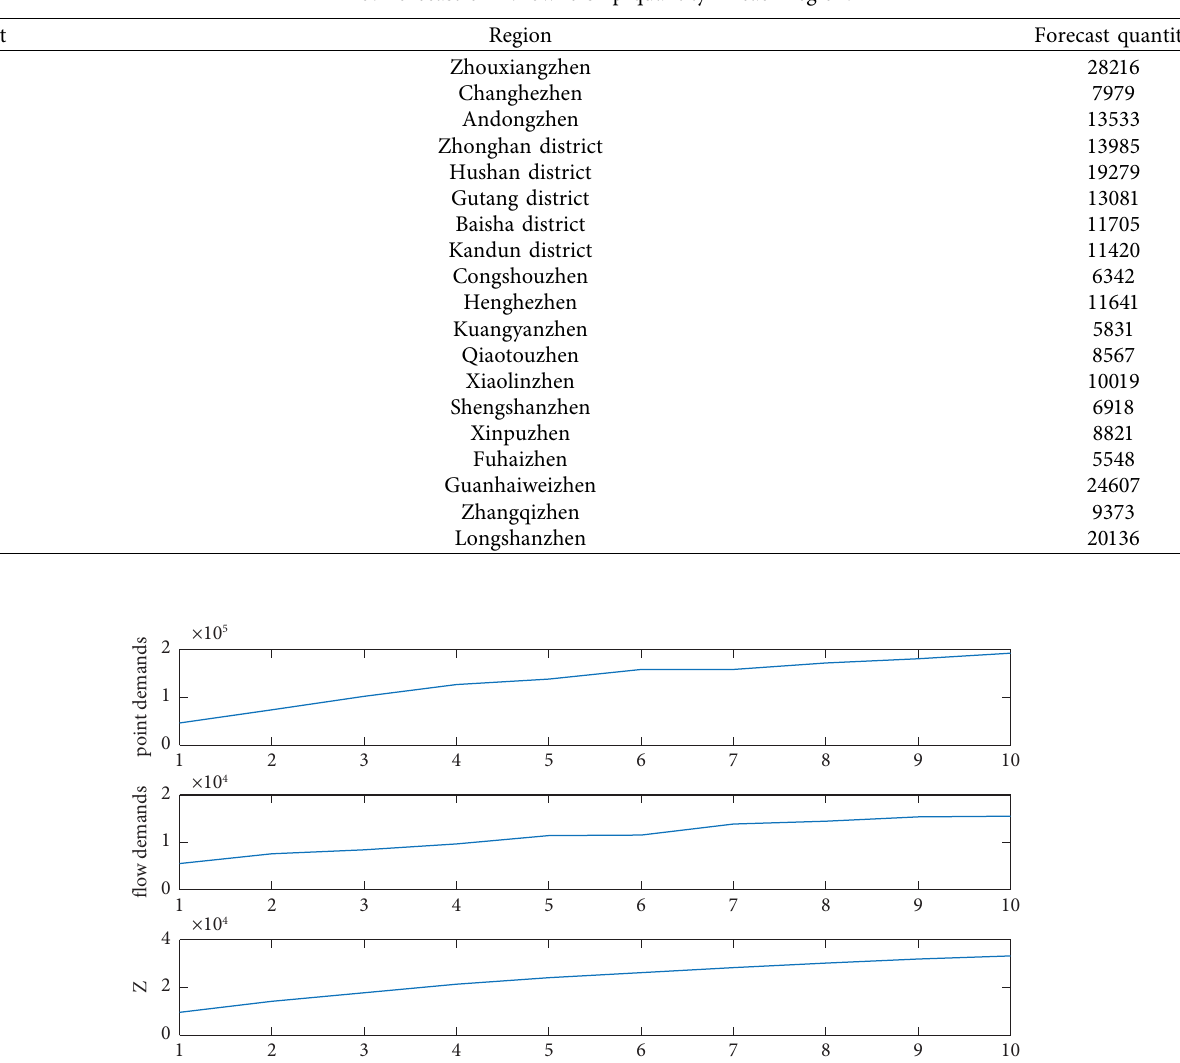
Table 3: Forecast of EV ownership quantity in each region.